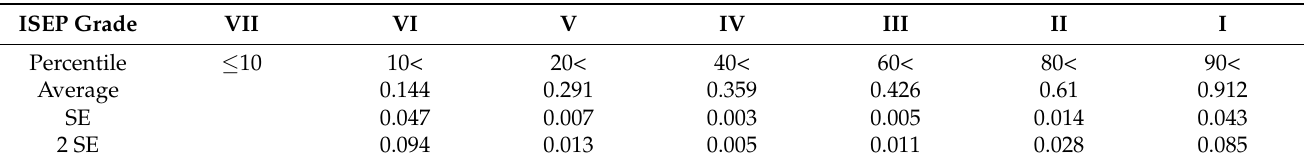
Table 1. ISEP grading criteria based on percentiles estimated from 5000 bootstrap samples (modified from Yoo et al.